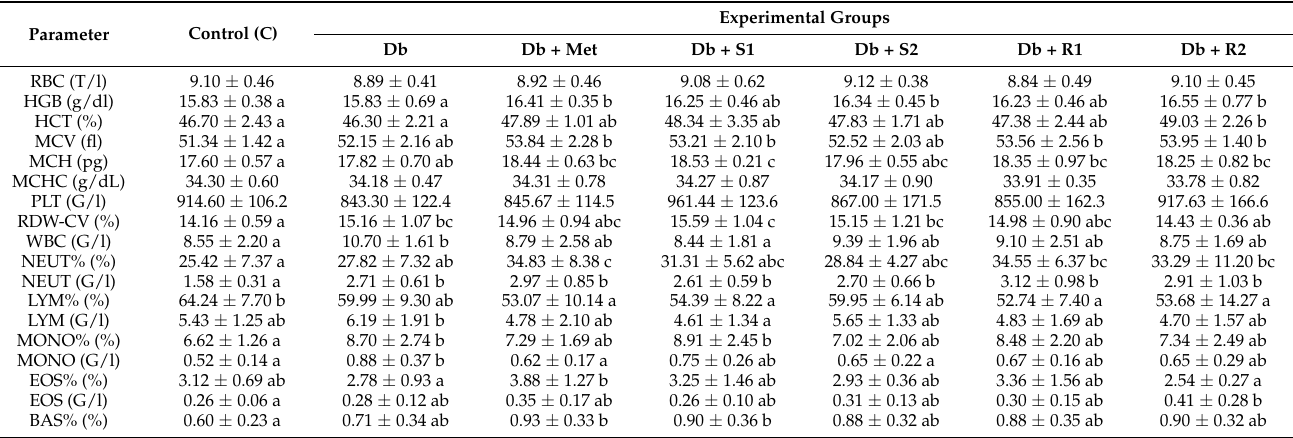
Table 3. Effect of diet and supplementary SGs on blood Hematological indices in rats.